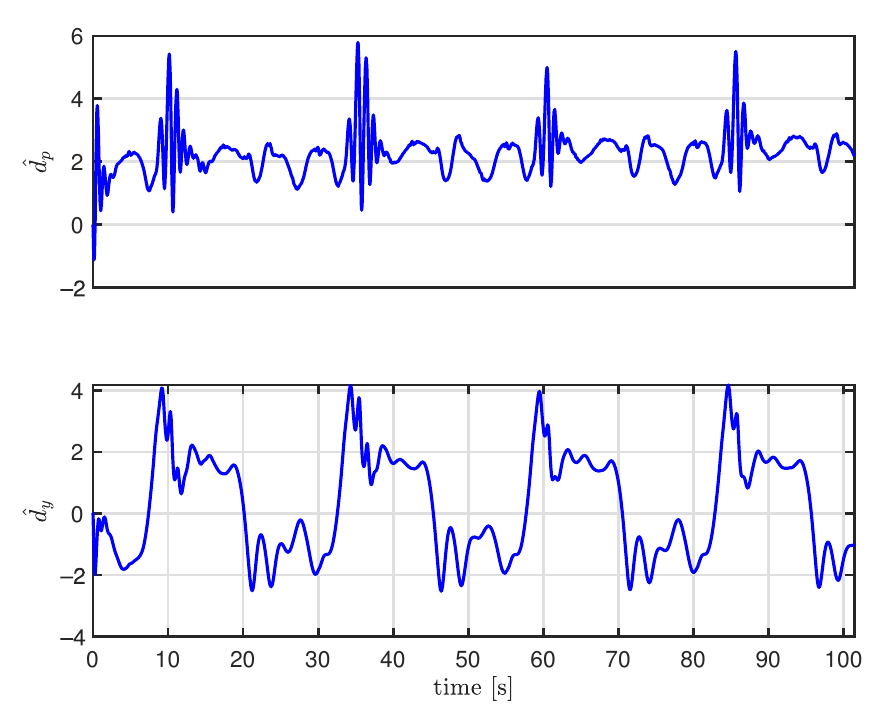
Figure 16. Estimated disturbances (Case